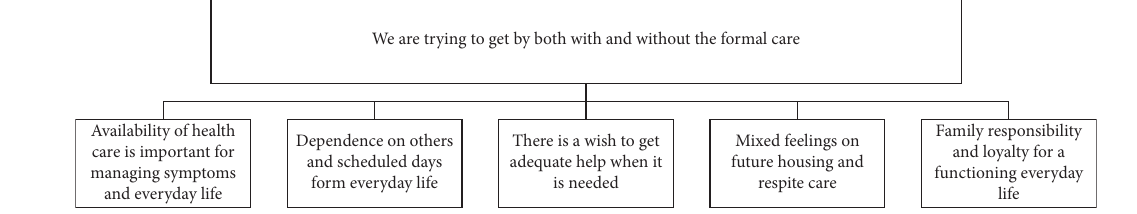
Figure 1: Main category with five subcategories which illustrate the patients’ and informal caregivers’ experiences of health and social care in late-stage PD in